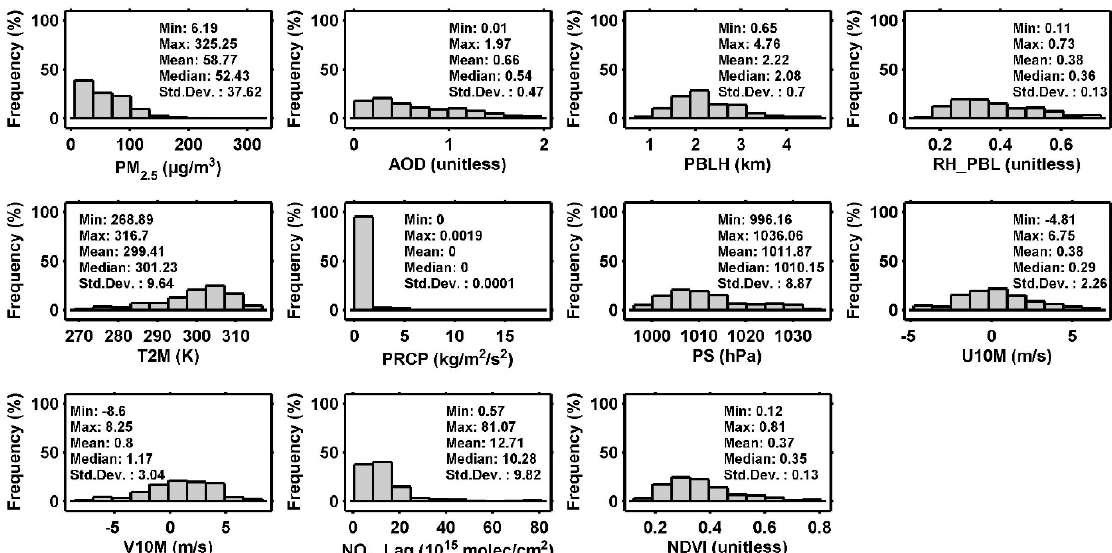
Figure 2. Seasonal-spatial distribution of VIIRS IP AOD ( A ) coverage and ( B ) average. ( a – e ) correspond to spring, summer, autumn, winter, and annual in subfigures ( A ) and ( B ).